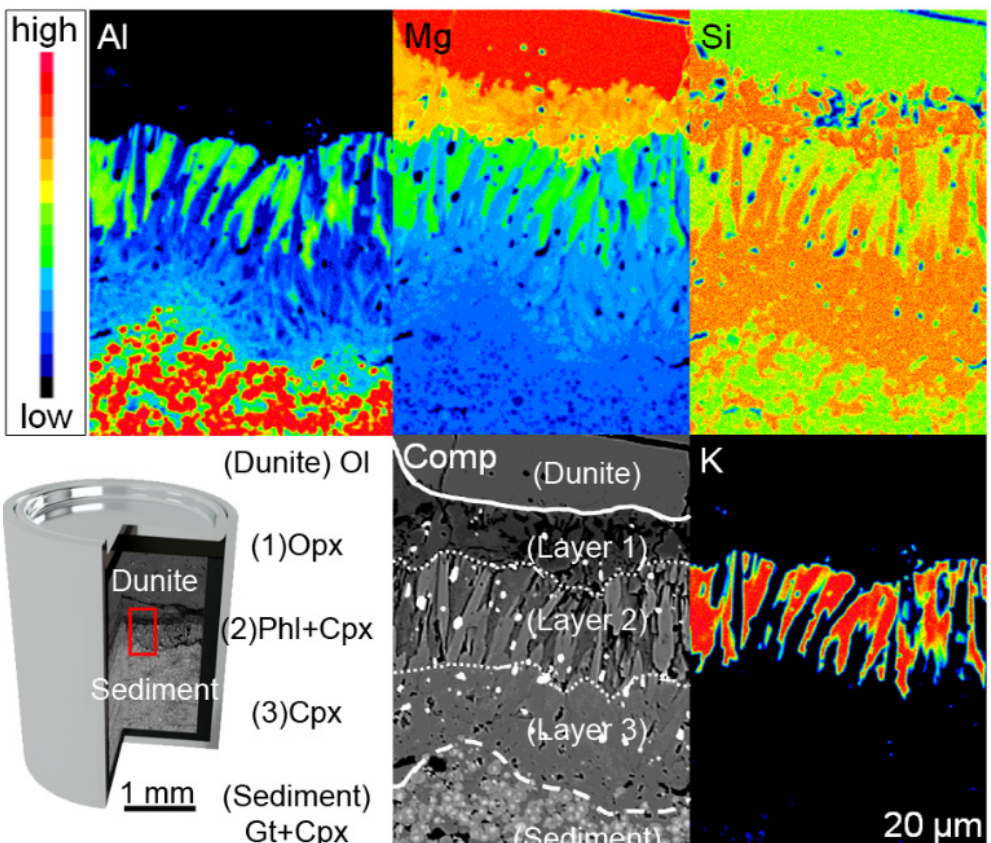
Figure 2. EPMA WDX- and LA-ICP-TOFMS maps of an experiment at 3 GPa/850 °C. Backscattered electron image (Comp) and qualitative WDX maps showing the distribution of Al, Mg, Si, and K in the reaction zone between dunite and partially molten sediment. Al is highest in garnet grains of the eclogite-like residue of the former sediment (red in Al map) and in phlogopite grains in the reaction zone (green), while clinopyroxene grains show a gradual increase in Al towards the former sediment (blue gradient in Al map). Mg shows a gradual decrease away from the dunite and is higher in phlogopite than in adjacent diopside. Si is high in clinopyroxene and orthopyroxene (both orange in Si map). K is strongly enriched in phlogopite (red in K map), where it forms a symplectite with diopside (dark blue in Al map). Phase abbreviations: Phl—phlogopite, Cpx—Clinopyroxene,